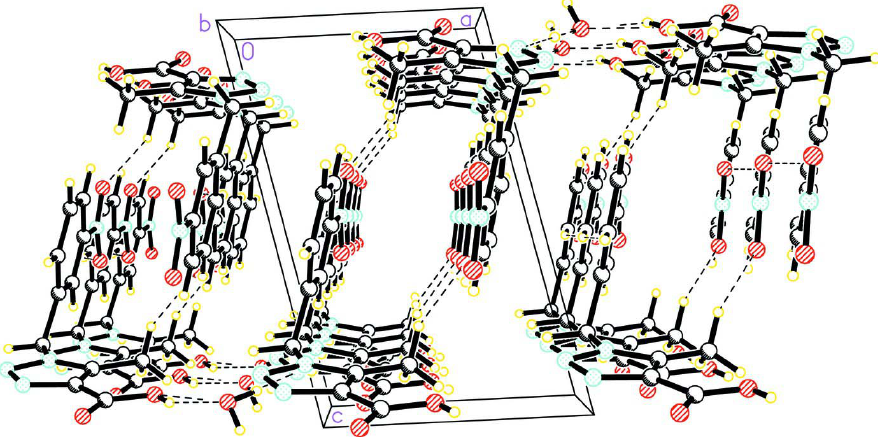
Packing diagram of the title compound, showing the crystal structure along the b